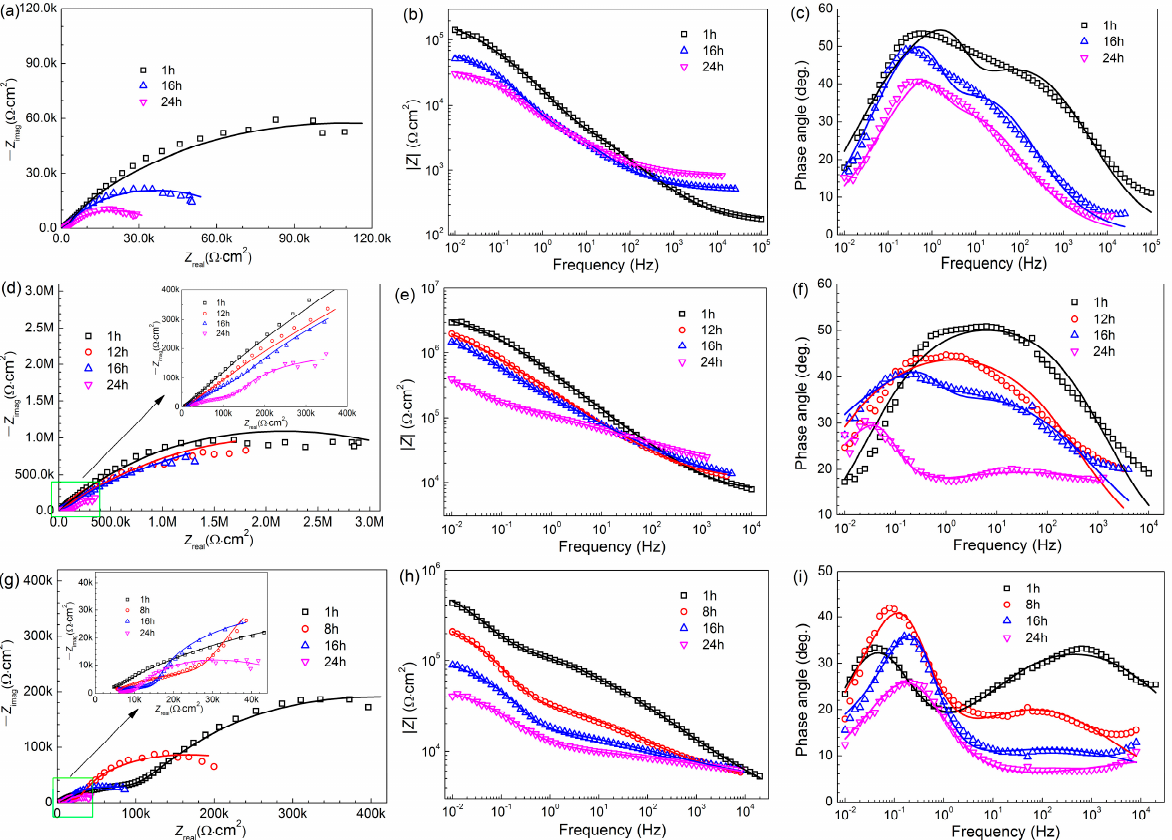
Figure 8. Nyquist spectra and Bode plots of HC-15 ( a – c ), HC-30 ( d – f ) and HC-60 ( g – i ) in 3.5 wt.% NaCl. Symbols represent